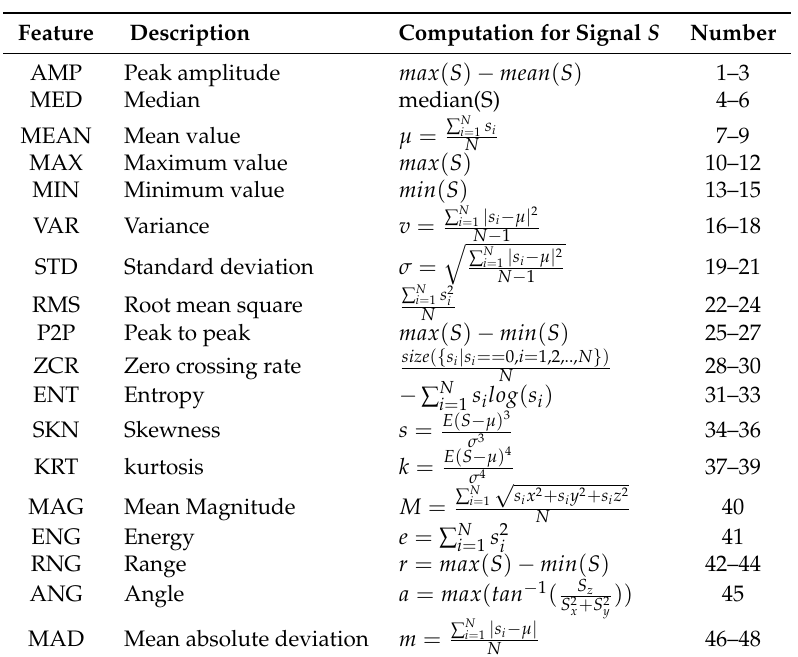
Table 1. Extracted time-domain features. S = ( S x , S y , S z ) is a vector of the tri-axial accelerometer readings, where, S x , S y , and S z are vectors of accelerometer readings in vertical, lateral, and horizontal directions, respectively. S i = ( S ix , S iy , S iz ) shows a reading of tri-axial accelerometer at timestamp i . E ( . ) represents the expected value of the input variable. Functions min ( . ) , max ( . ) , mean ( . ) , median ( . ) , tan − 1 ( . ) , size ( . ) compute the minimum, maximum, average, median, inverse tangent, and size of an input